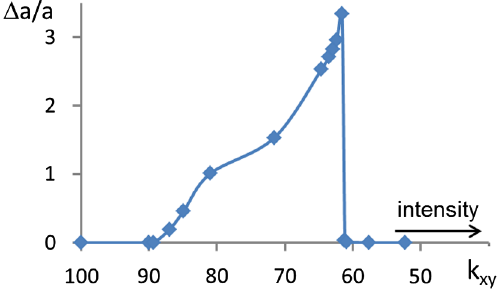
FIG. 2. Complete stopband with relative growth of rms enve- lopes for fixed k 0 x;y ¼ 100 ° as function of k x;y